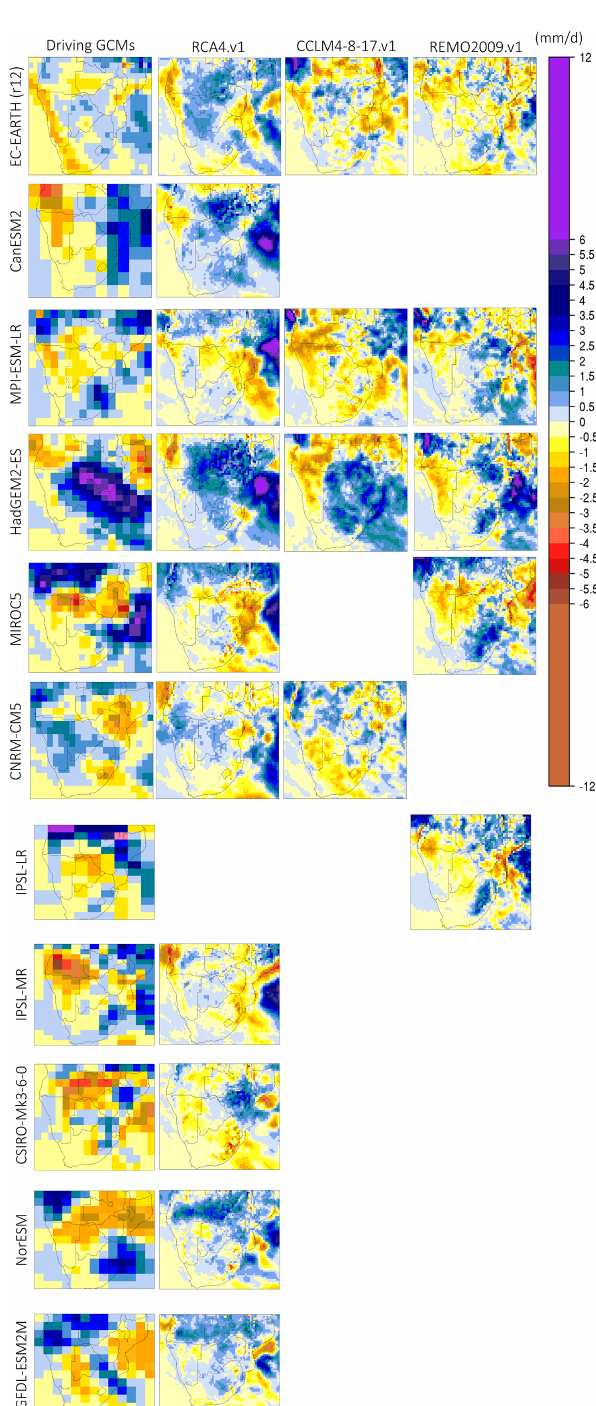
Figure 11. Monthly precipitation change (future–present, in mmd − 1 ) during January for the period 2065–2095 relative to 1985–2005. The first column (from the left) displays precipitation change for the driving GCMs used, and columns 2–4 display the downscaled products according to RCA4.v1, CCLM4-8-17.v1, and